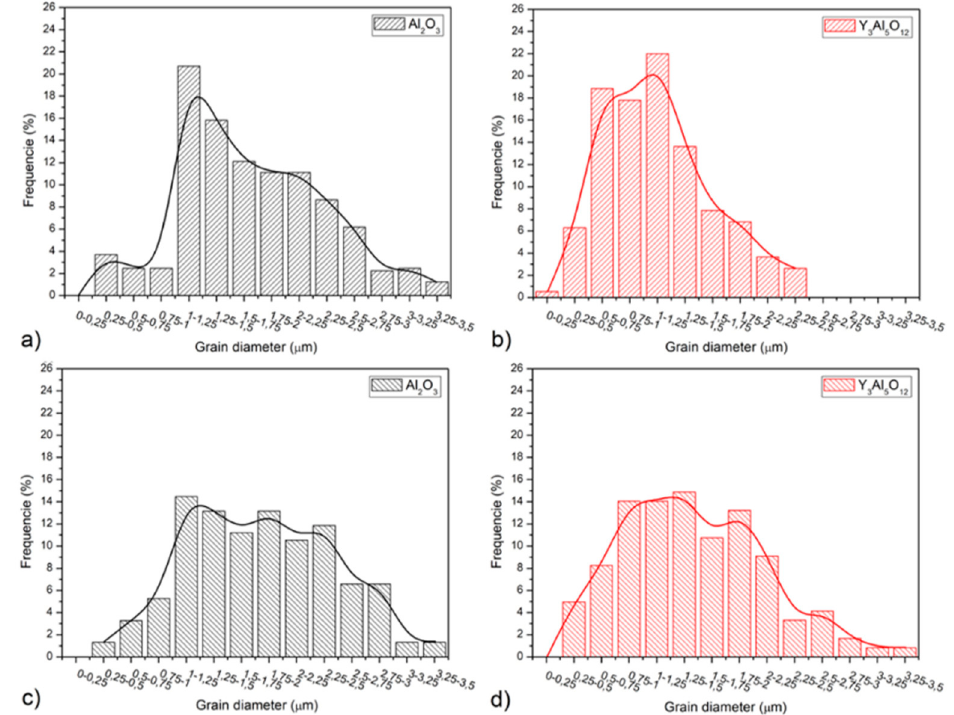
Figure 8. Grain size distribution of sintered Al 2 O 3 –YAG composites: ( a ) and ( c ) represent the Al 2 O 3 grain size distribution for samples sintered at 1600 ◦ C for 2 h and 1650 ◦ C for 2 h; and ( b ) and ( d ) represents the Y 2 Al 5 O 12 grains size distribution for samples sintered at 1600 ◦ C for 2h and 1650 ◦ C for 2